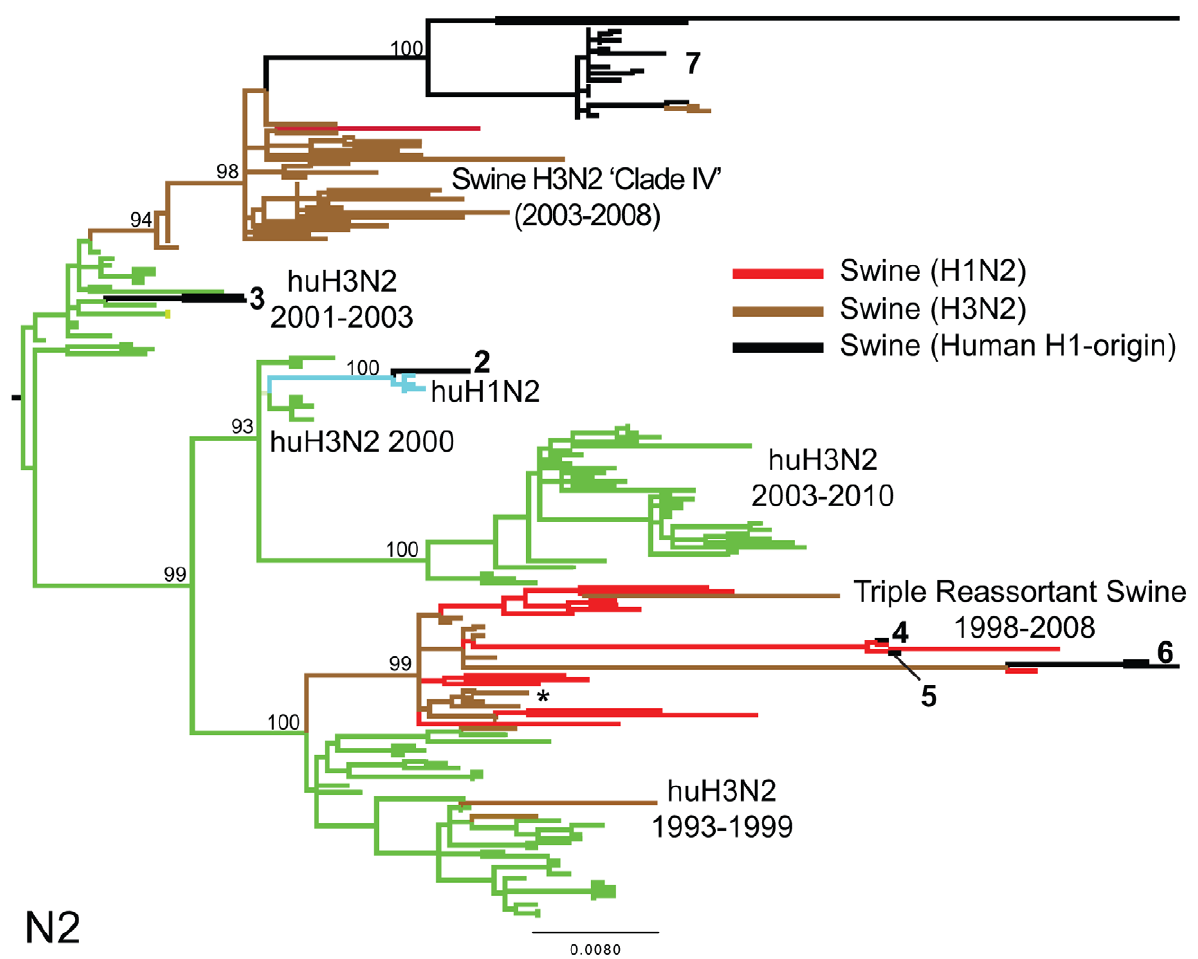
Figure 4. Phylogenetic relationships of the NA (N2) segment. Phylogenetic relationships of the NA (N2) segment (1,407 nt) of 28 human- origin H1 swine influenza viruses, 5 representative human H1N2 influenza viruses, 99 representative H3N2 human influenza viruses, and 60 classical and triple reassortant swine influenza viruses, collected in 1998–2009. Rooting, scaling, labels, and color-coding are identical to Fig. 3, with the addition of ‘Swine H3N2 Clade IV’. Phylogenetic relationships of the N1 sequences (n=3) contained in cluster 1 are depicted in Fig.